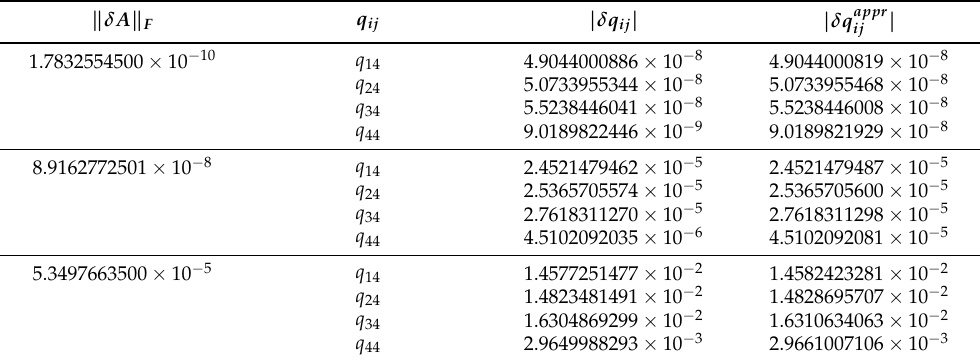
Table 8. Approximated perturbations of the elements of Q 2 and their